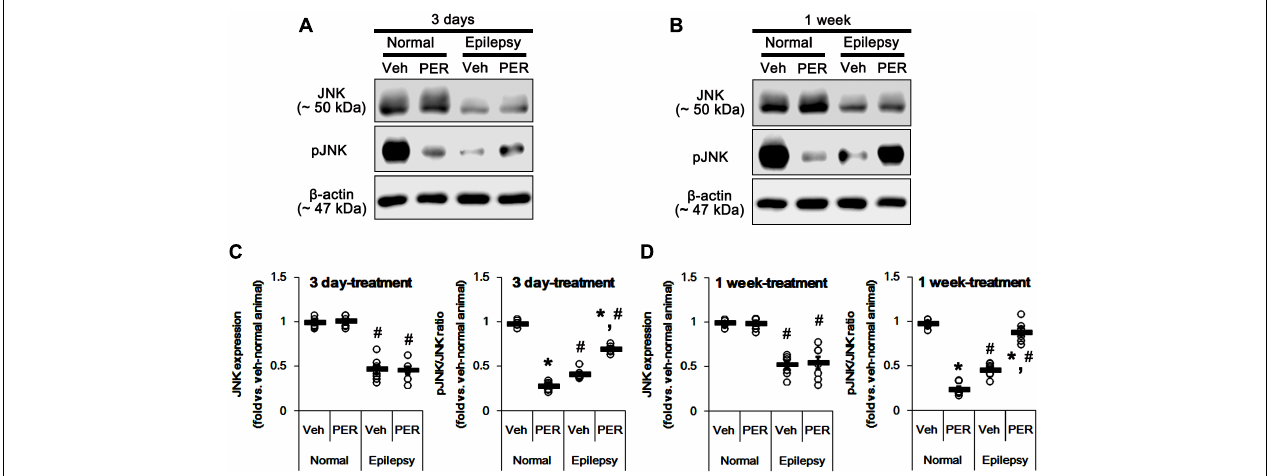
FIGURE 8 | Effects of perampanel on JNK expression and its phosphorylation. (A,B) Representative images for western blot of JNK and phospho (p)-JNK in the hippocampal tissues obtained from 3-days (A) and 1-week treated groups (B) . (C,D) Quantifications of JNK and pJNK levels in 3-days (C) and 1-week treated groups (D) . Open circles indicate each individual value. Horizontal bars indicate mean value. Error bars indicate SEM ( ∗ , # p < 0.05 vs. vehicle-treated animals and normal animals, respectively; n = 7, respectively).